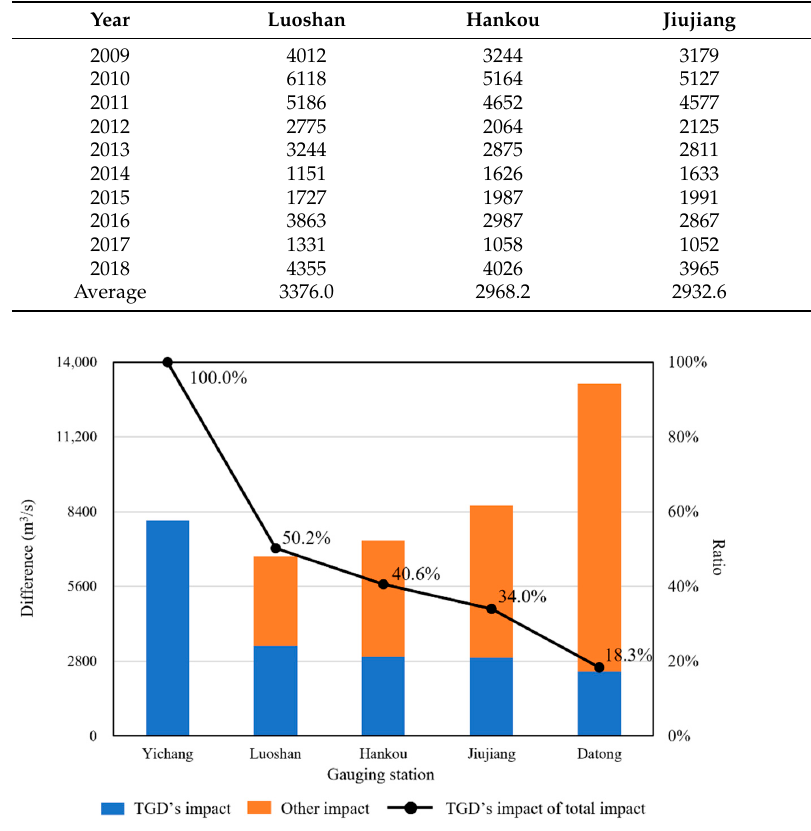
Figure 8. The TGD’s impact on five gauging stations after its full operation based on an analysis of the maximum 1-day discharge. These results were calculated from the average of the difference between the observed maximum 1-day discharge and the reconstructed maximum 1-day discharge after the full operation of the TGD (see Tables 3 and 4). The TGD’s impact on the Luoshan, Hankou, Jiujiang, and Datong gauging stations was calculated by the Muskingum routing model based on the TGD’s impact on the Yichang gauging station, assuming that the Yichang gauging station is completely controlled by the